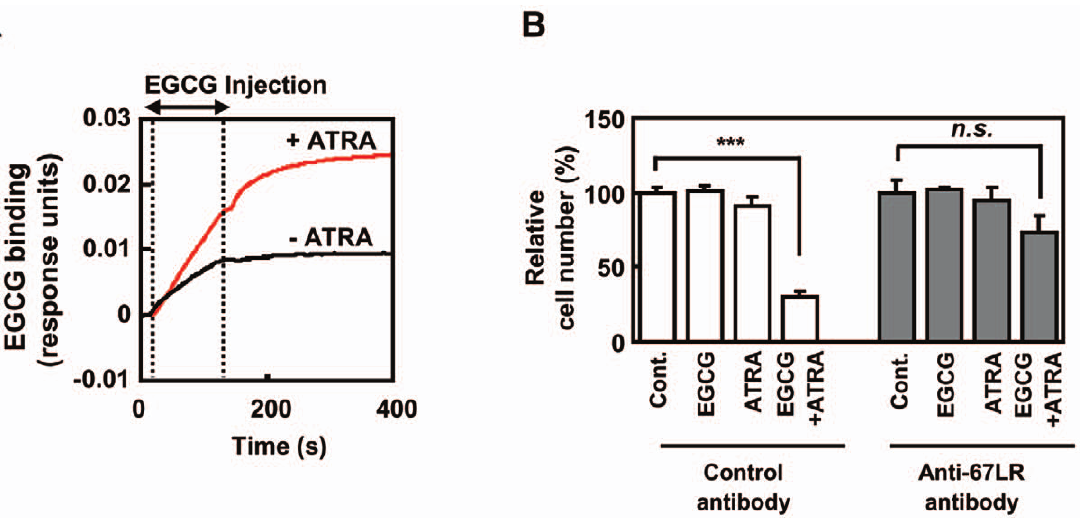
Figure 2. ATRA induces the EGCG activity through the enhancing of EGCG binding to 67LR. A ) EGCG binding to the surface of B16 cells treated with (red line) or without (black line) ATRA monitored by surface plasmon resonance. EGCG was injected at a concentration of 5 m M for the indicated time interval ( + EGCG). B ) B16 cells treated with 0.1 m M ATRA in DMEM supplemented with 1% FCS for 48 h. Then, the cells were treated with either anti-67LR (MLuC5) or control antibody (mouse IgM) for 2 h and then the cells were added to 0.5 m M EGCG for 48 h. Cell proliferation was assessed by the WST-1 reagent. Cell number was measured as 430 nm absorbance and shown as relative of control. Data shown are means 6 S.D. for three samples. Data containing asterisk marks are significantly different from the values in control at *** p ,